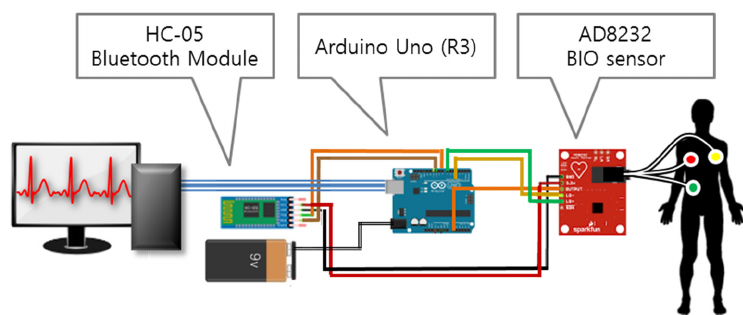
Figure 1. Composed pulse measuring equipment.